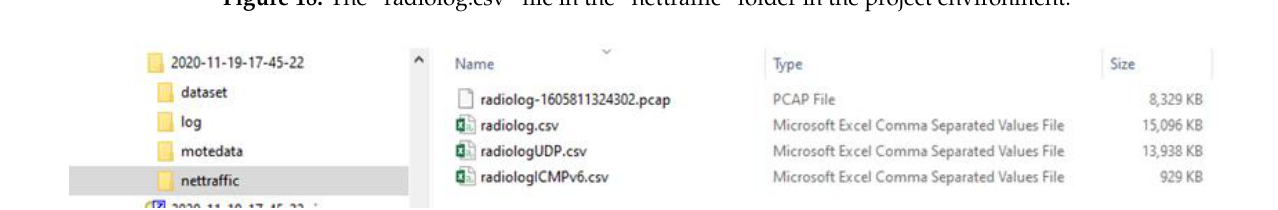
Figure 18. The “radiolog.csv” file in the “nettraffic” folder in the project environment.